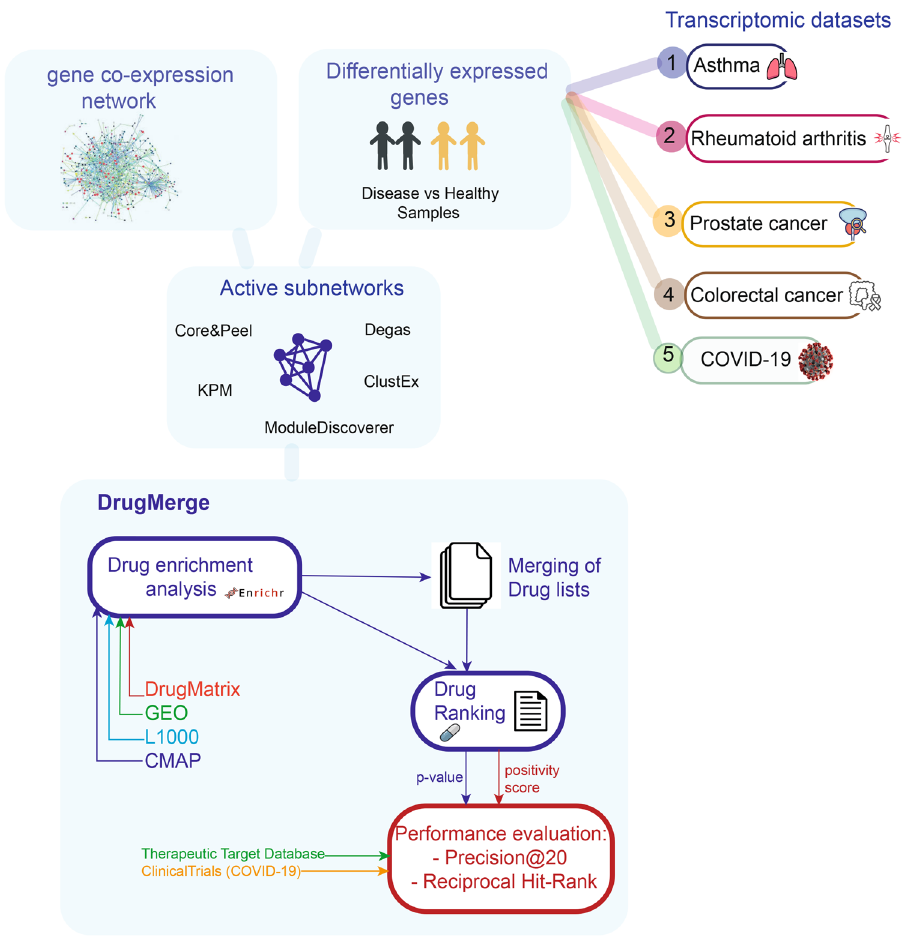
Figure 1. Overview of the workflow. The first part of the figure shows how we generated the data inputs of DrugMerge. These data have been created in Lucchetta et al. 4 , and we reported them here for sake of completeness. We used several transcriptomic data to identify differentially expressed genes and the gene co-expression network to find one active subnetwork for each method used (Core&Peel, ModuleDiscoverer, Degas, ClustEx, and KeyPathwayMiner). For each of them, we performed the drug enrichment analysis on four drug perturbation databases: DrugMatrix, GEO, L1000, and CMAP. After that, we ranked the drugs according to the p-value or the positivity score. We also merged more drug lists, which come from different algorithms for the same disease and we applied the same ranking strategy. Finally, we evaluated the DrugMerge performance through the Precison@20 and the Reciprocal Hit-Rank using the golden-standard drugs, collected in the Therapeutic Target Database, and ClinicalTrials for COVID-19. The image has been created using Adobe